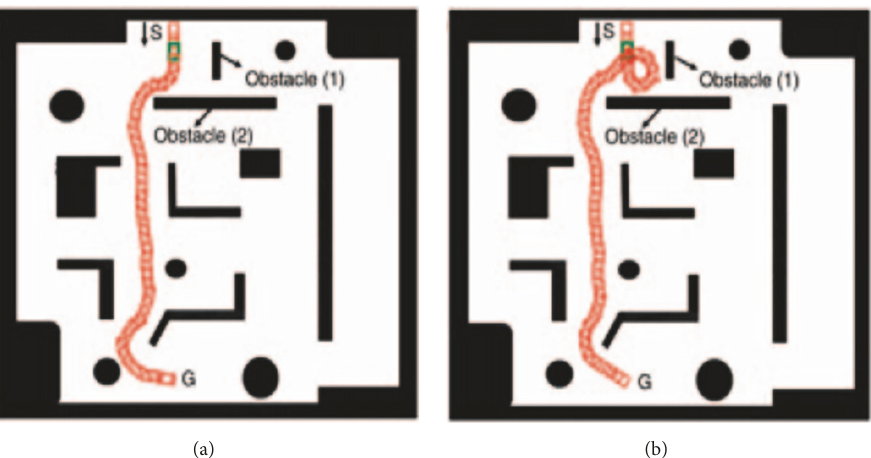
Figure 6: Mobile robot obstacle avoidance using DRNFS with short memory (a) compared to conventional fuzzy rule-based (b) navigation system from a given start (S) and goal (G) positions (source